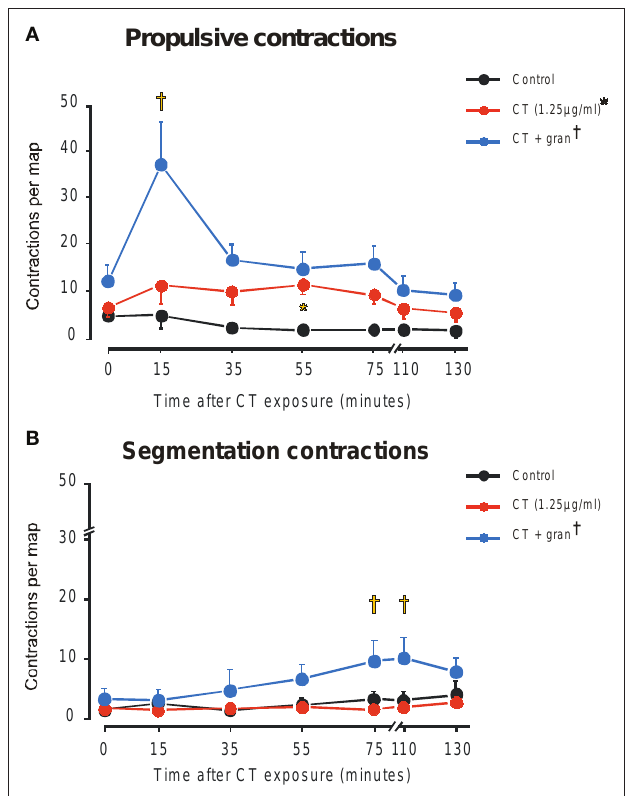
Figure 2 | Propulsive (A) and segmentation (B) contractions in control (black), CT (1.25 μg/ml, red), CT plus gran (blue). Curve differs from control (* P < 0.0001), curve differs from CT alone († P < 0.0001), CT plus gran differs from CT alone (‡ P < 0.001, propulsive; P < 0.05